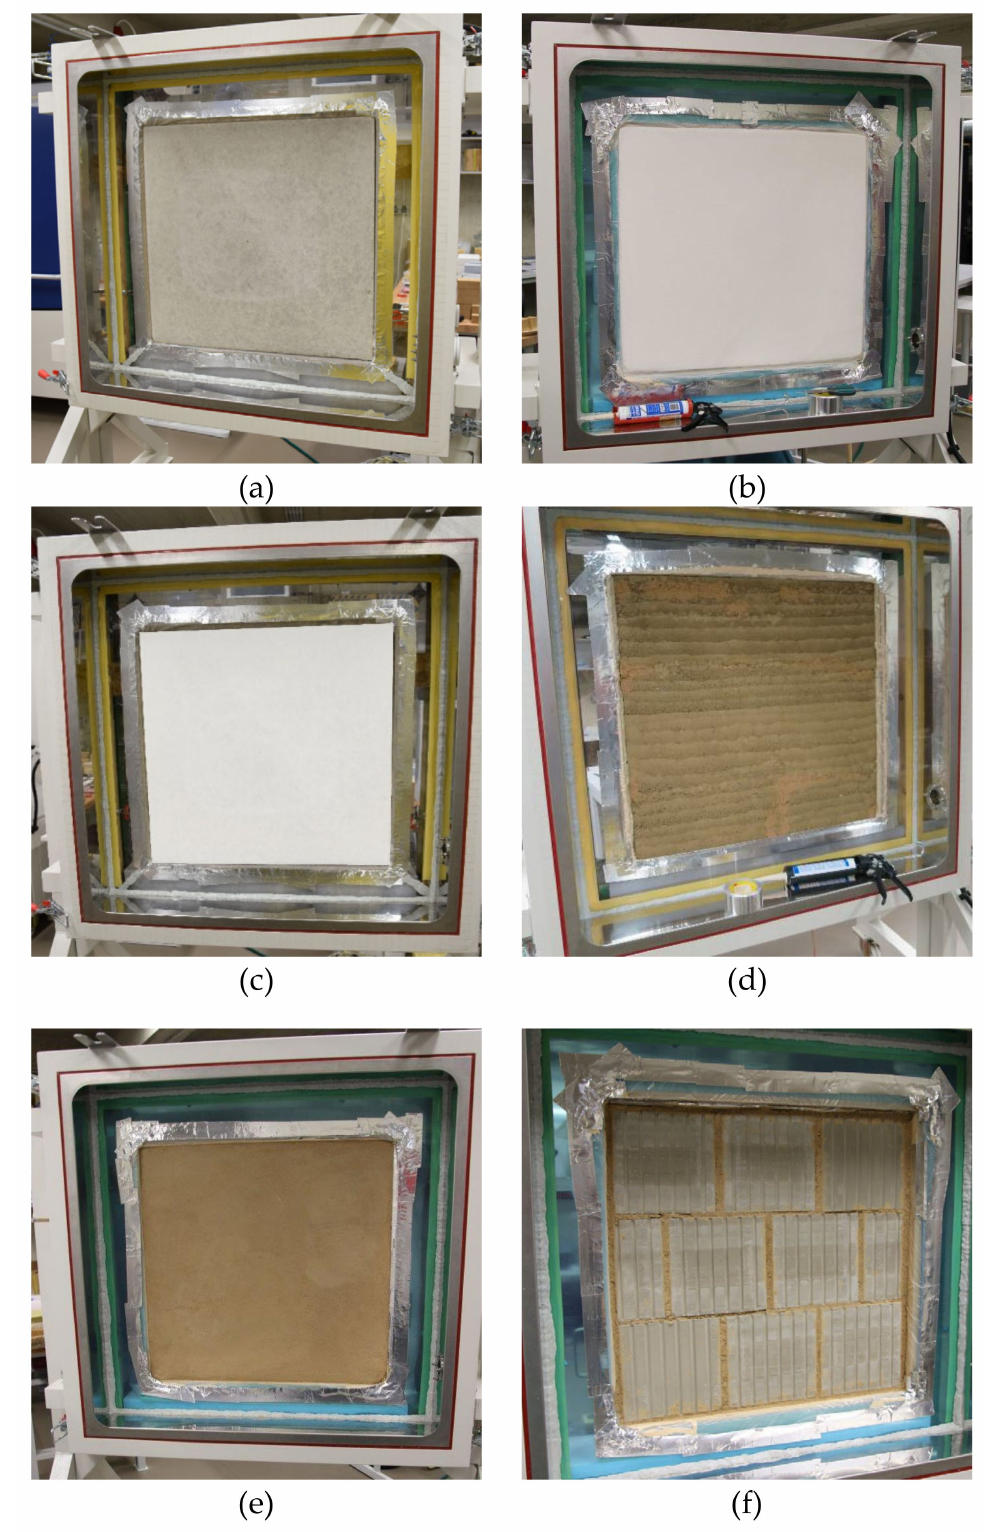
Figure 7. Testing wall elements in the climatic chamber: ( a ) concrete wall; ( b ) ceramic hollow blocks with lime plaster; ( c ) partition wall from gypsum board; ( d ) rammed earth panel (C_S10/W10); ( e ) unburned clay hollow blocks with clay plaster; ( f ) fair-face brickwork from unburned clay hollow